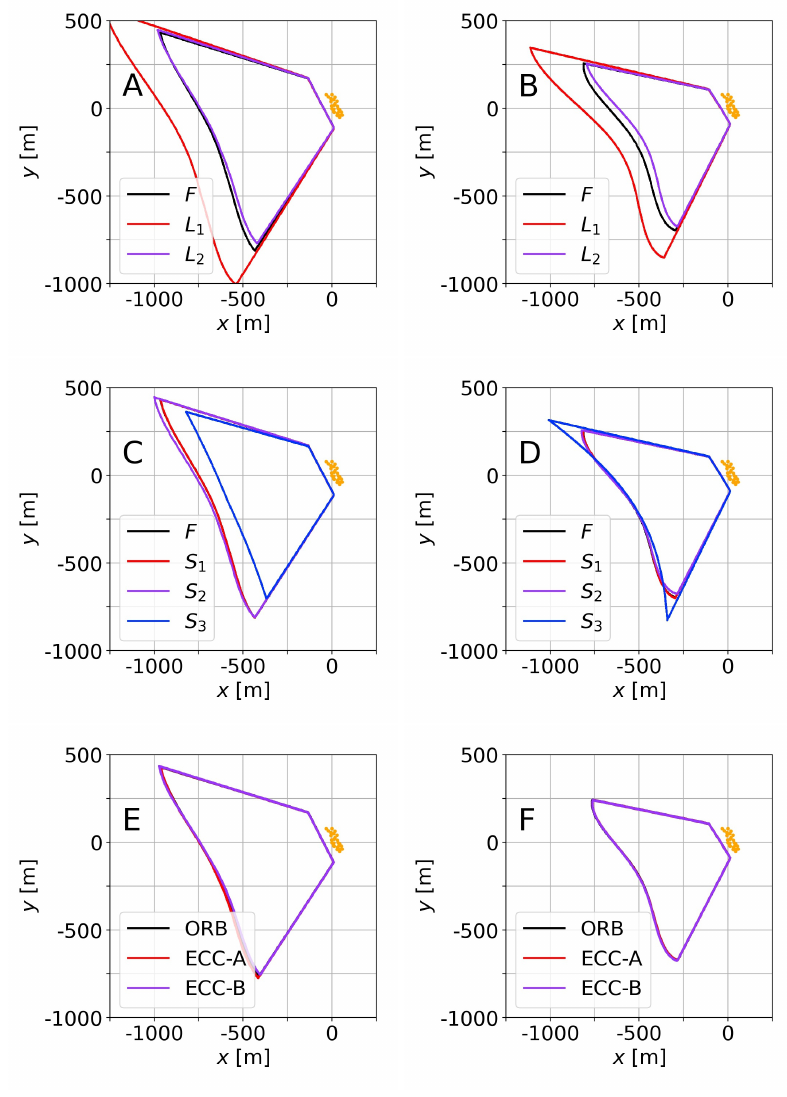
Figure 15. Influence of several aspects on the domains obtained for video 1 ( A , C , E ) and video 2 ( B , F , D ): influence of using the intrinsic calibration from field ( F , with n I = 5) and from laboratory ( L 1 and L 2 ) (plots A , B ); influence of the simplifications of the camera governing equations ( C , D ); and, influence of the GCP tracking approach (E and F). In all cases, GCPs are marked with orange points. Table 3. RMSE and bias, for ε (cid:54) ε 0 , of the inferred bathymetry for different simplifications in the governing